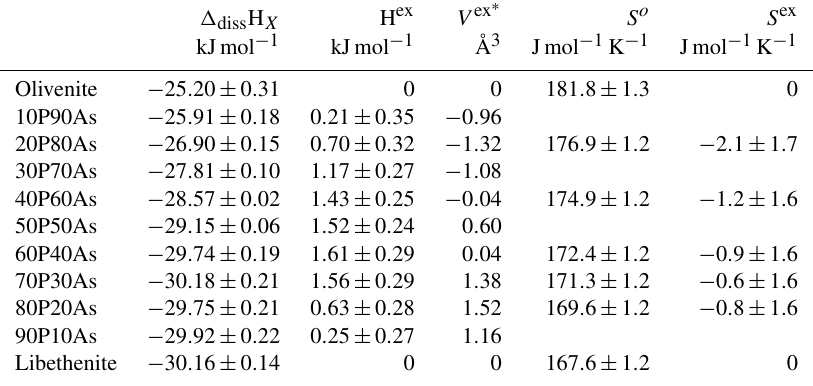
60P40As − 29 . 74 ± 0 .